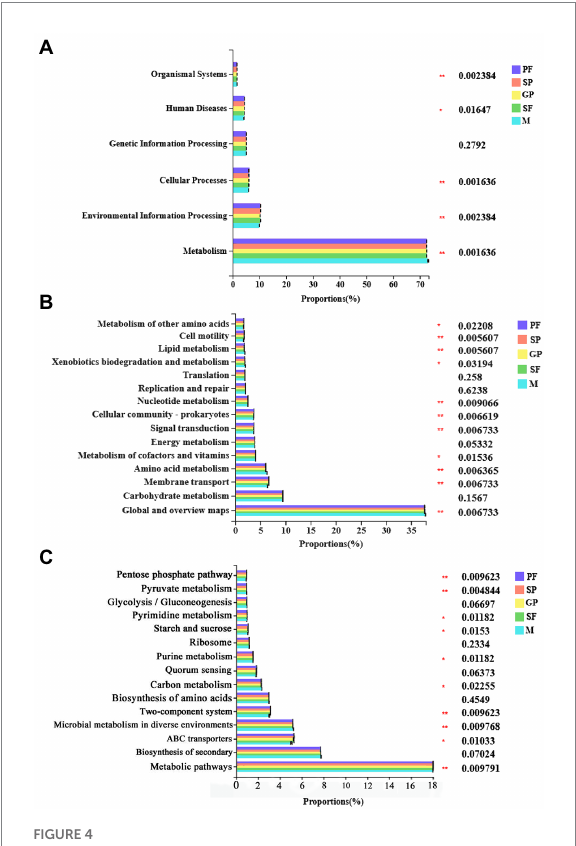
FIGURE 4 Functional prediction of symbiotic bacteria in five reproductive mode shift of cotton aphid. KEGG categories were derived from the 16S rRNA sequences of cotton aphid microbiome by PICRUSt2. (A) Level 1: 6 categories of biological functions of bacterial community. (B) Level 2: top 15 function pathways enriched with highest-richness bacteria. (C) Level 3: Function pathways enriched with the highest-abundance bacteria in all five morphs. Statistical significance of bacterium relative abundance proportions enriched in KEGG pathways among five reproductive morphs was determined by Tukey–Kramer test at p ≤ 0.05 (*) or p ≤ 0.01 (**) (FDR adjusted) with 95% confidence intervals. PF, parthenogenetic females; SP, sexuparae; GP, gynoparae; SF, sexual females; M,